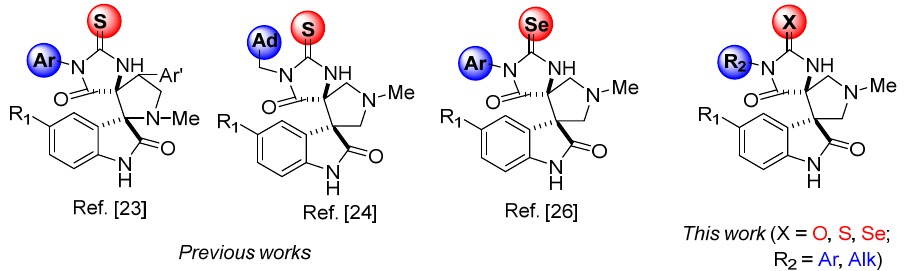
Figure 1. Compounds synthesized earlier and in this